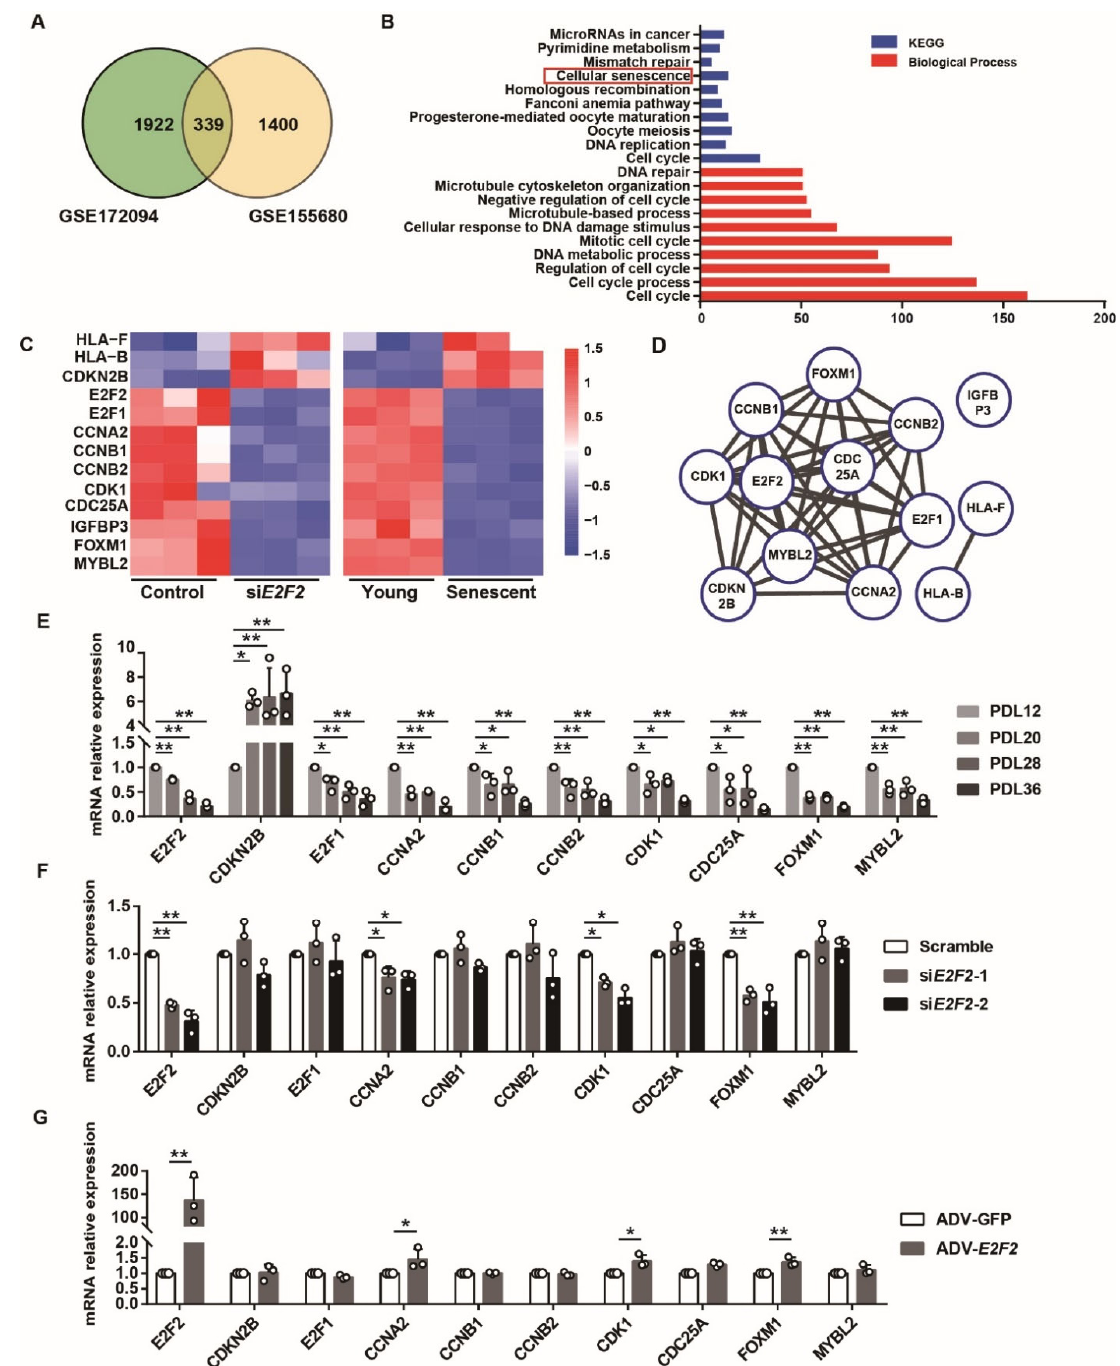
Figure 6. Identifying differentially expressed genes (DEGs) in E2F2 -knockdown and senescent en- dothelial cells. ( A ) Venn diagram for the intersection of DEGs in E2F2 -knockdown and senescent cells. GSE172094: siRNA-mediated E2F2 silencing in growth-stimulated prostate cancer cells; GSE155680: young and senescent endothelial cells; log2 Fold Change ≥ 0.5, qvalue < 0.05. ( B ) KEGG and GO enrichment analysis for DEGs in signaling pathways. ( C ) A heatmap of 13 DEGs associated with cellular senescence. The color intensity denotes the relative gene expression, upregulation (red), and downregulation (blue). ( D ) A gene interaction network for targeted genes related to cellular senescence by String. qPCR for mRNA expression of 10 DEGs in HUVECs with different PDLs ( E ), E2F2 -knockdown HUVECs (PDL12) ( F ) and E2F2 -overexpressed HUVECs (PDL36) ( G ). One-way ANOVA for statistical comparison. Values are mean ± S.D. * p < 0.05, ** p <